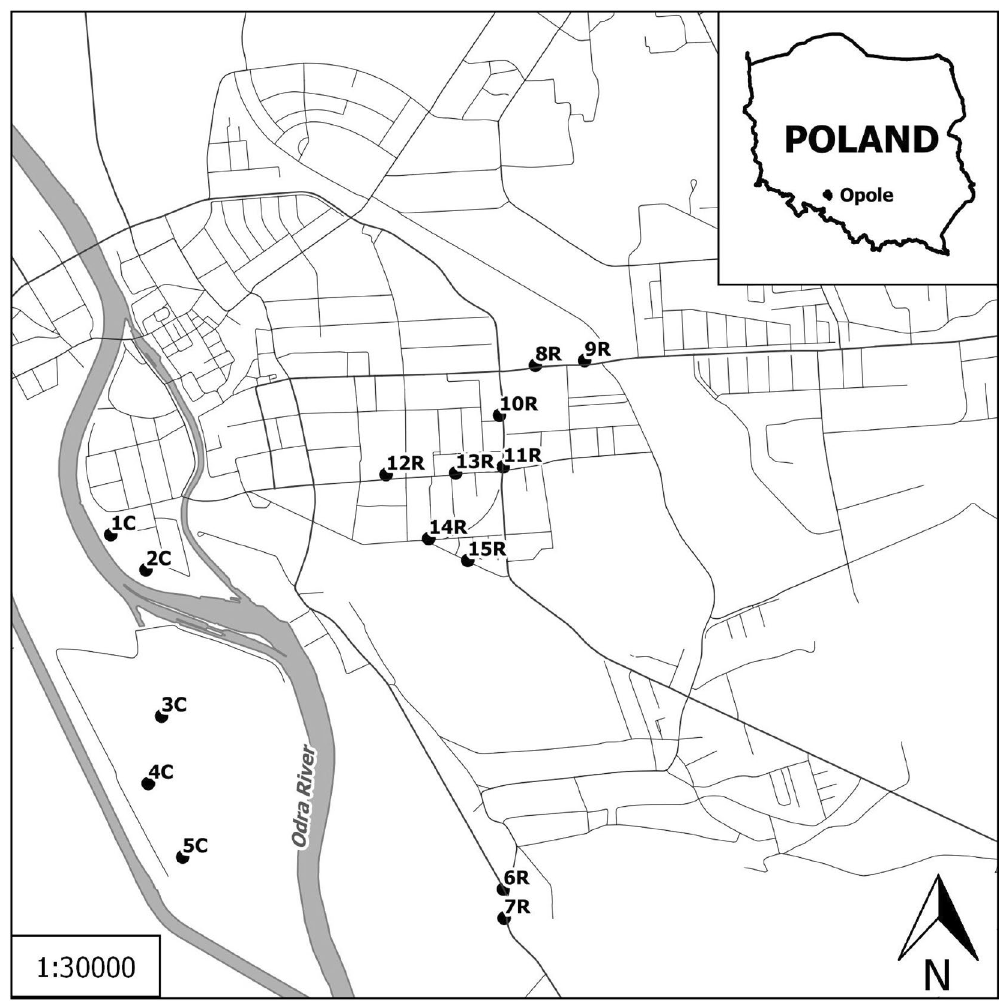
Figure 1. The geographic position of Opole and the location of the studied sites. C park, R roadside (The map has been made based on OpenStreetMap data, using QGIS 2.14. Essen).